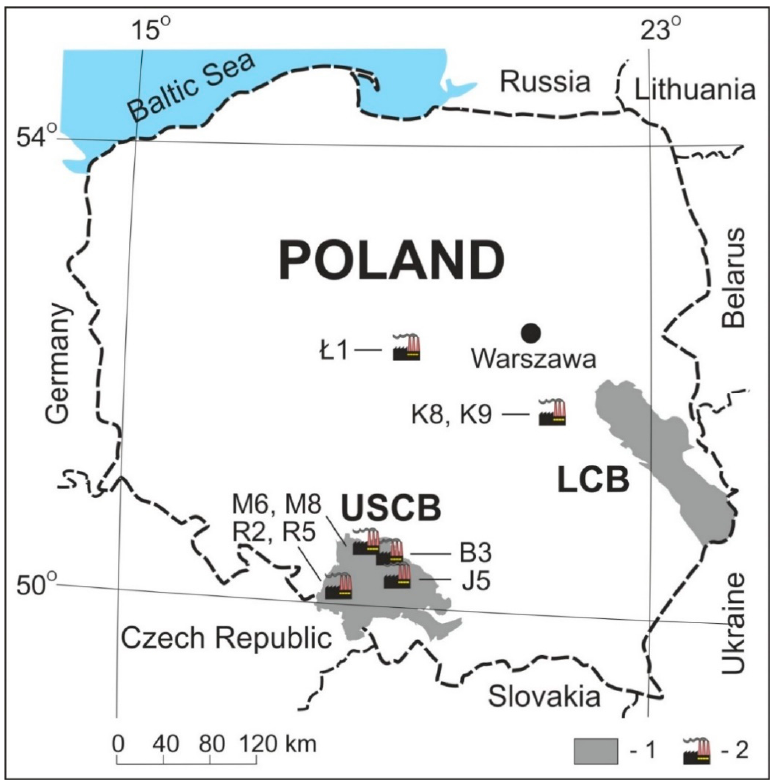
Figure 1. Location of studies area and sampling point: (1) basin areas; (2) power stations that burn coal from LCB (samples symbol: K9, Ł1) and from the USCB (B3, J5, M6, M8, R2, R5; see Supplementary Materials Table S1).